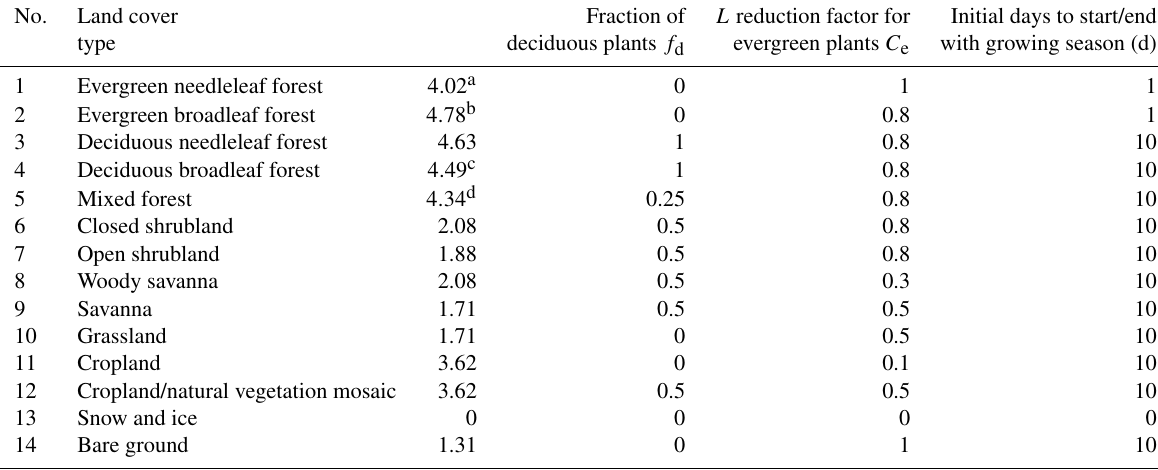
Figure C1. Land cover classification of WaterGAP 2.2d. Table C1. Parameters of the leaf area index model from Müller Schmied et al. (2014).